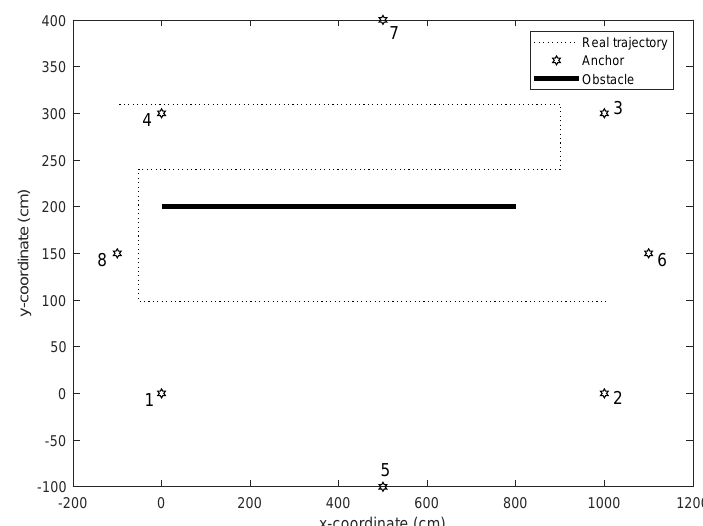
Figure 1. Simulation environment setting and real trajectory.